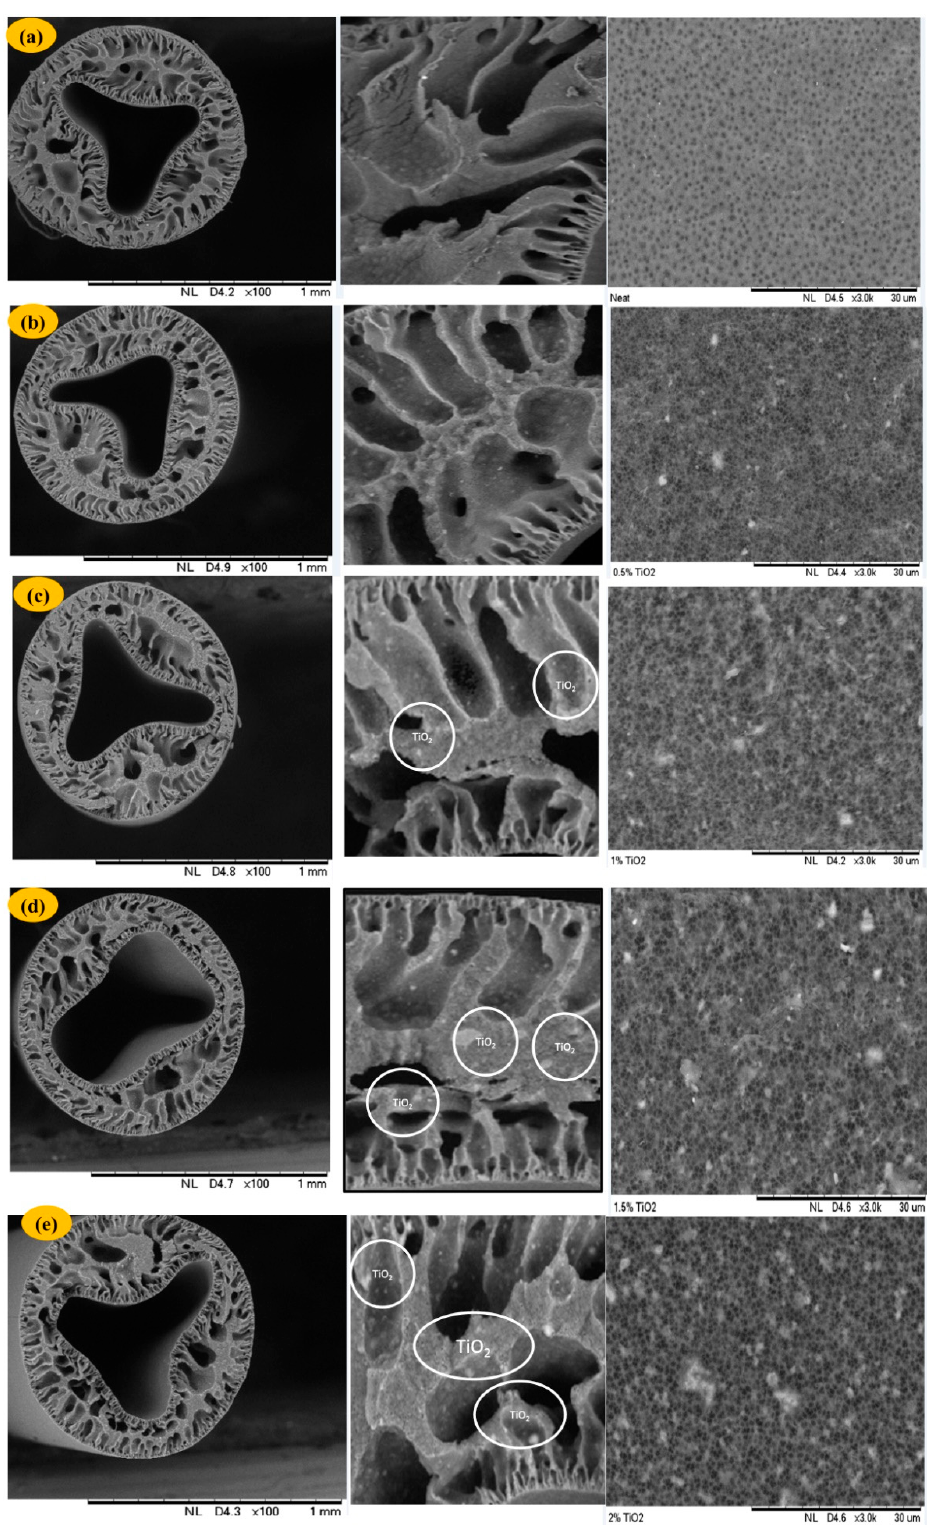
Figure 1. Scanning Electron Microscopy (SEM) pictures (cross and exterior surface) of polyvinylidene fluoride (PVDF) membranes made from separate levels of TiO 2 : ( a ) 0, ( b ) 0.5, ( c ) 1.0, ( d ) 1.5, and ( e ) 2.0 wt% in the presence of polyvinyl pyrrolidone (PVP).